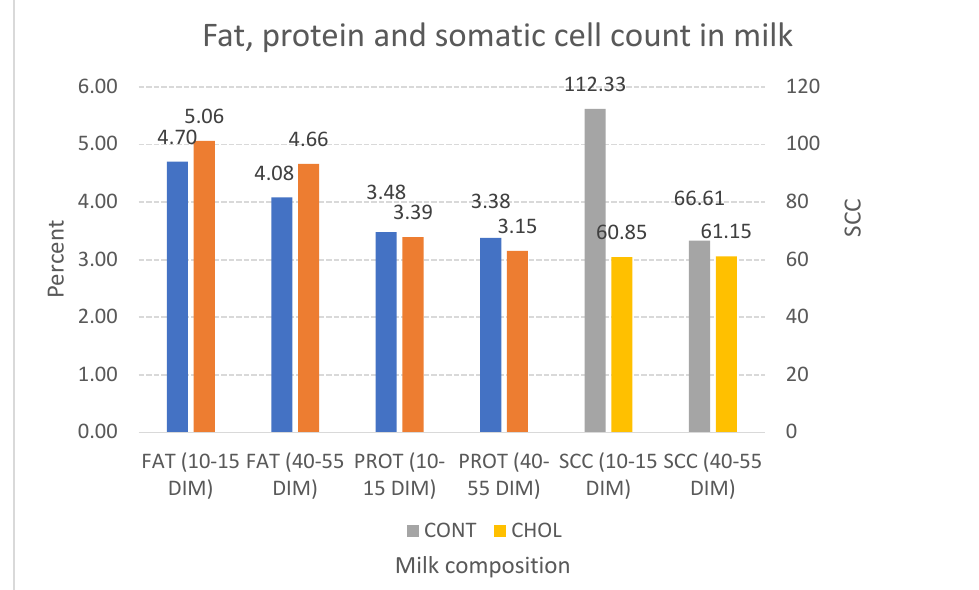
Figure 4. Milk composition of the CHOL and CONT groups at 10–15 and 40–55 DIM.